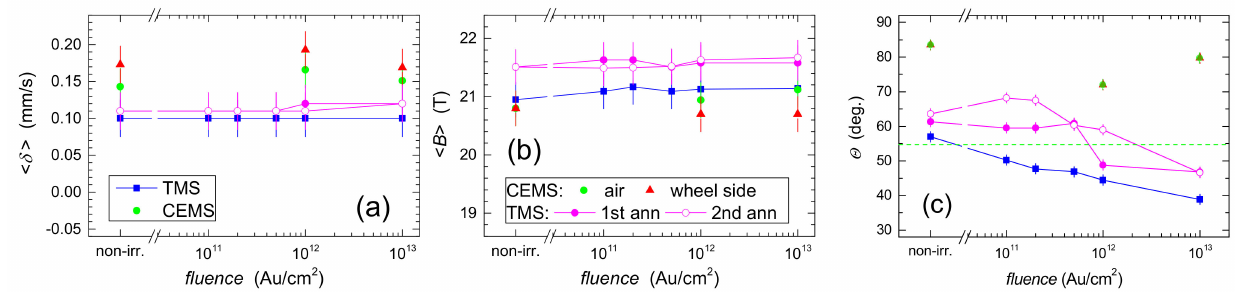
Figure 22. Parameters derived from transmission (TMS, blue) and CEMS (green) Mössbauer spectra of Fe 74 Cu 1 Nb 3 Si 16 B 6 irradiated by 593 keV Au ions plotted against the ion fluence: ( a ) average isomer shift, (cid:104) δ (cid:105) ; ( b ) average hyperfine magnetic field, (cid:104) B (cid:105) ; ( c ) angle Θ . Red triangles correspond to CEMS spectra taken from the wheel side of the ribbons. Parameters corresponding to the annealed samples are plotted in magenta. Dashed line in ( c ) represents Θ -values that correspond to random orientations of spins. Solid lines are only guides for the